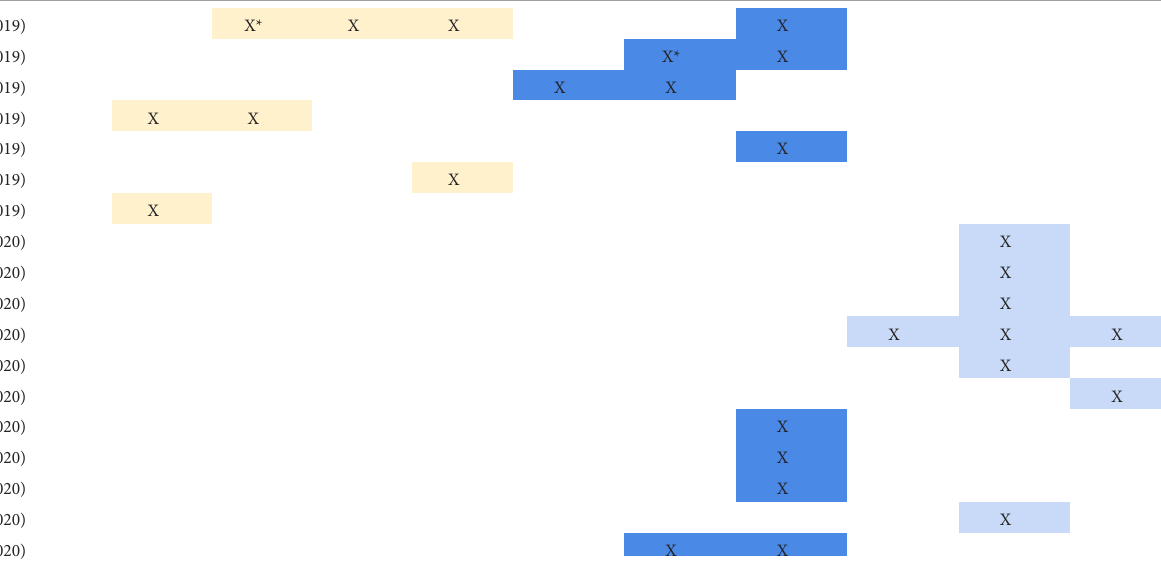
TABLE 1 Spawning activity relative to the night after full moon (NAFM), where X indicates that a given colony spawned on a given night. Coral (Year of